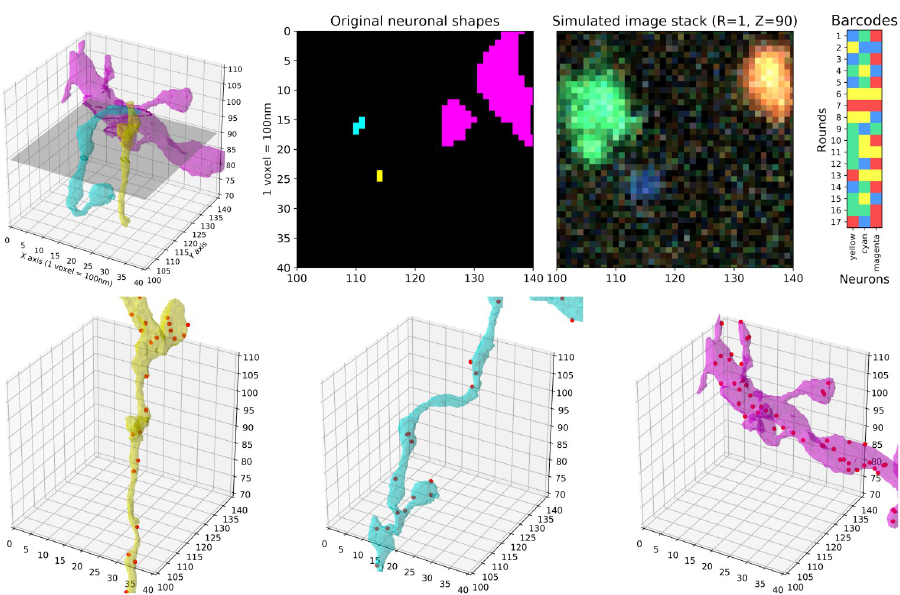
Fig 2. Simulation process illustration. Top left : Three neuronal segments in a small region (40 × 40 × 40 voxels with 100 × 100 × 100 nm voxel size). The original EM data is much more densely packed than what is shown here; for illustration purposes, we only show three neurons among many. Top middle : A 2D slice with each neuronal segment uniquely colored (left) and the simulated imagestack at the same plane for the first sequencing round (right). The imagestack colors do not correspond to neural segment colors, but rather to the corresponding fluorescent barcodes (top right). A video corresponding to this plot, showing multiple z-planes, can be found at this link. Bottom : Amplicons are uniformly simulated within neuronal segment volumes; simulated amplicons are shown as red